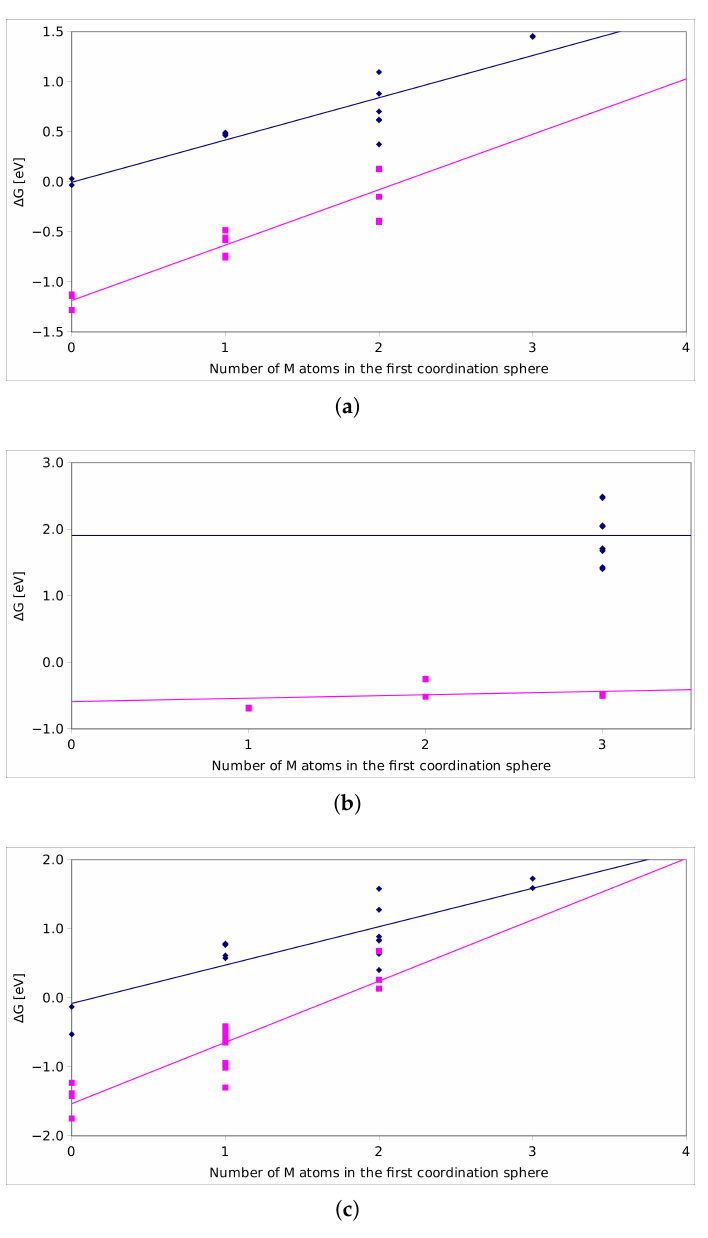
Figure 5. The relation between the ∆ G and the number of Ti atoms ( a ), Al atoms ( b ) and Si atoms ( c ) in the first coordination sphere. The purple and blue series represent the location of the site in first and second atomic layer,